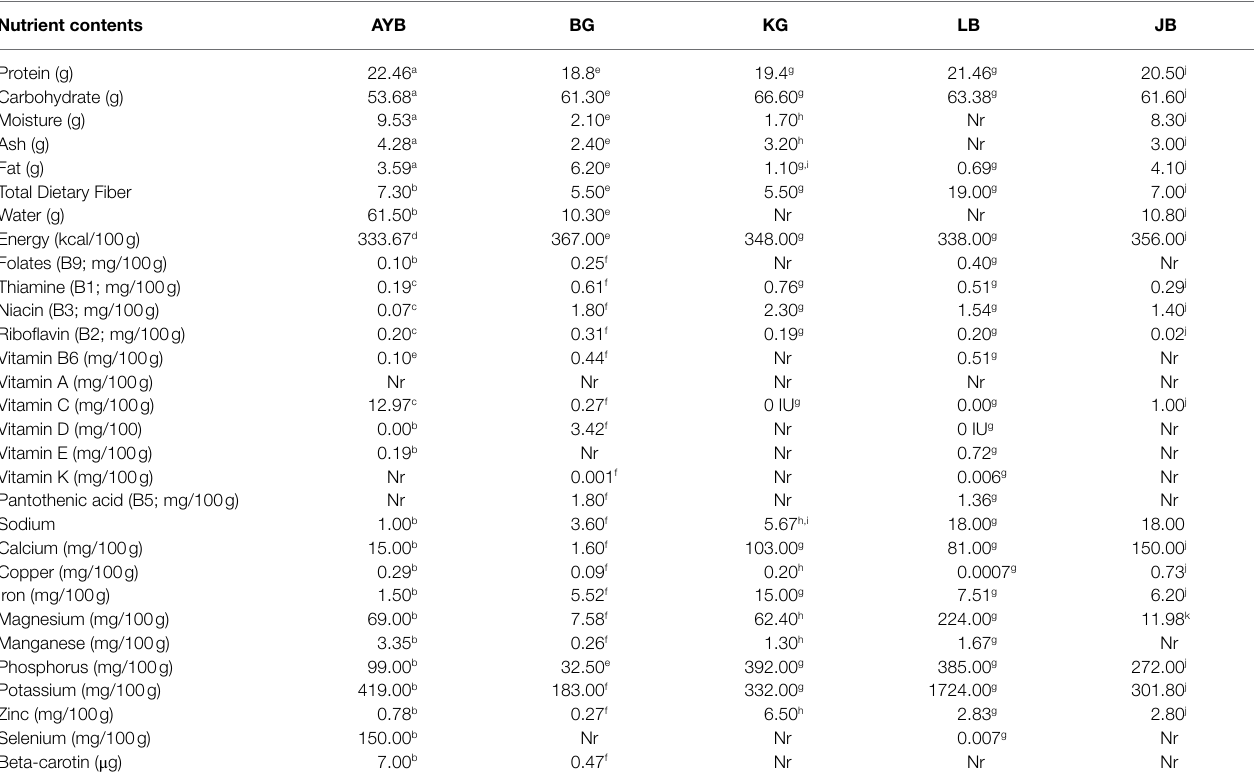
TABLE 5 | Nutritional profile of raw, mature seeds, and values per 100 g of five orphan legume